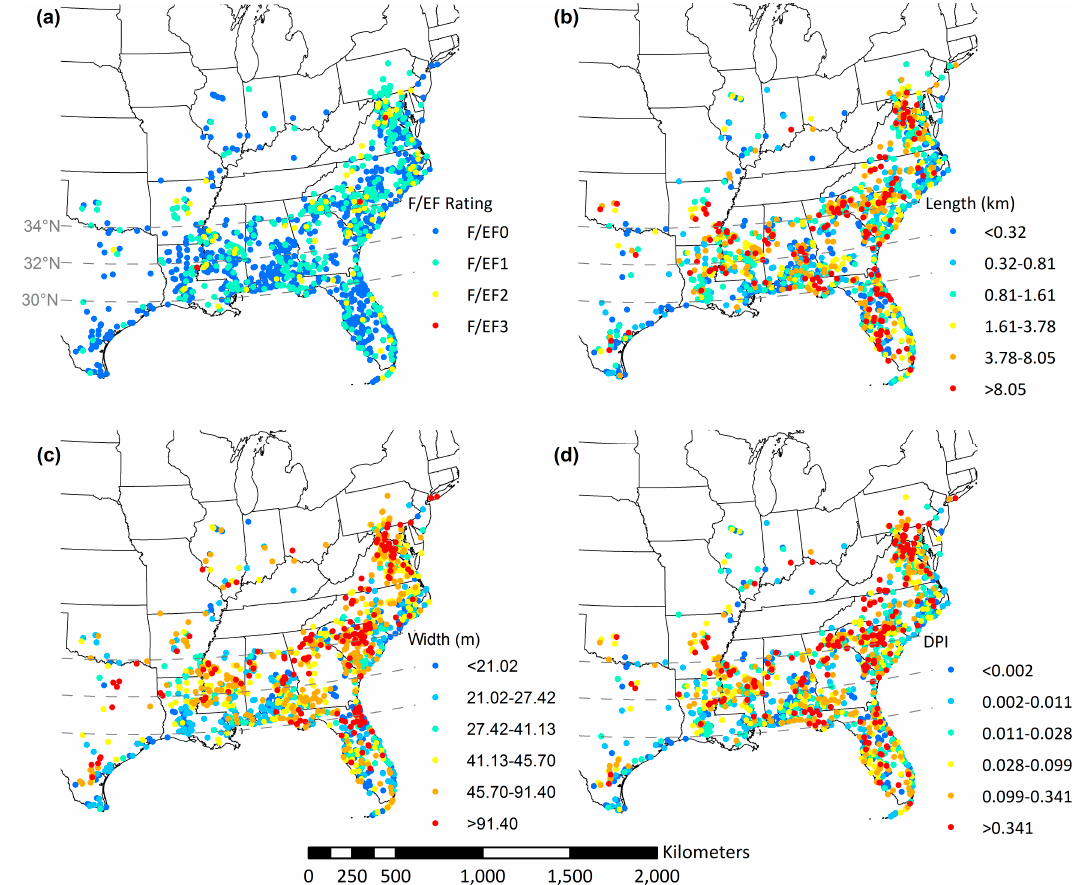
Figure 2. Spatial distribution of 1285 TC tornadoes, stratified by F/EF scale ( a ), path length ( b ), path width ( c ), and DPI ( d ). The distributions of length, width, and DPI are divided into quintiles.